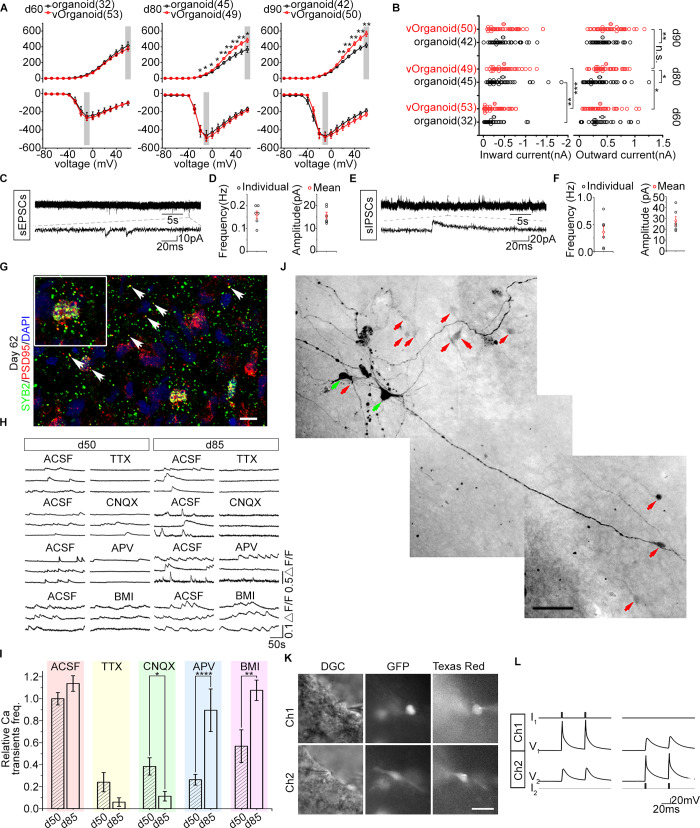
Electrophysiological properties of cells in the vOrganoids at different developmental stages.(A) The amplitudes of outward (upper) and inward (lower) currents from the organoids (black) and vOrganoids (red) cells at day 60 (32 cells from 5 organoids in 4 independent experiments; 53 cells from 8 vOrganoids in 6 independent experiments), day 80 (45 cells from 6 organoids in 4 independent experiments; 49 cells from 6 vOrganoids in 4 independent experiments, p-values: 0.0428, 0.0278, 0.0222, 0.0171, 0.0085, 0.0066, 0.0072, 0.0099, and 0.0131 when evoked voltages are −20, −10, 0, 10, 20, 30, 40, 50, and 60 mV) and day 90 (42 cells from 6 organoids in 4 independent experiments; 50 cells from 6 vOrganoids in 5 independent experiments, p-values: 0.0090, 0.0027, 0.0033, 0.0025, and 0.0018 when evoked voltages are 20, 30, 40, 50, and 60 mV). Two-sample t test, data shown as mean ± SEM, *p < 0.05, **p < 0.01, ***p < 0.001. (B) The amplitudes of outward currents elicited by +60 mV (indicated by gray box in upper panel of A) and the amplitudes of inward currents elicited by −10 mV (indicated by gray box in lower panel of A) from organoid (black) and vOrganoid (red) cells at day 60, day 80, and day 90. Open circles indicate the amplitude of current from individual cells. Filled circles indicate the mean value. p-Values: 0.0108 (outward current of vOrganoid d60 versus d80), 0.0615 (outward current of vOrganoid d80 versus d90), 0.0131 (outward current at day 80 organoid versus vOrganoid), 0.0018 (outward current at day 90 organoid versus vOrganoid), 0.0066 (inward current of organoid d60 versus d80), 0.00001 (inward current of vOrganoid d60 versus d80). Two-sample t test, data shown as mean ± SEM, *p < 0.05, **p < 0.01, ***p < 0.001. (C-F) Spontaneous EPSCs (C) and IPSCs (E) were recorded in vOrganoids. The average frequency and amplitude of EPSCs and IPSCs are shown in (D) and (F), respectively. n = 6, 6 cells from 3 organoid and 3 vOrganoids in three independent experiments for sEPSCs (D) and sIPSCs (F), respectively. (G) Synapses in vOrganoids are revealed by immunofluorescence staining for the pre- and postsynaptic markers, SYB2 and PSD95, respectively. Scale bar, 10 μm. (H) Intracellular spontaneous calcium fluctuations were measured before and after the application of TTX, CNQX, APV, and BMI in the vOrganoids at day 50 and day 85, respectively. (I) The effects of different treatments on spontaneous calcium fluctuations were compared between day 50 and day 85 in the statistical results. Relative Ca2+ transient frequencies are normalized with the ACSF data of day 50. There are 188 and 124 cells in total for day 50 and day 85. All data are presented as means ± SEM. n = 188, 124, 31, 9, 65, 33, 77, 36, 15, and 46 from three independent experiments. Two-sample t test, p_ACSF = 0.1266, p_TTX = 0.2798, p_CNQX = 0.0208, p_APV = 0.00005, p_BMI = 0.0075. *p < 0.05, **p < 0.01, ***p < 0.001, ****p < 0.0001. (J) Coupling pattern was visualized by cell injection. Green arrows indicated the injected cells. Red arrows indicated the cells that were connected to the injected cells. Scale bar, 50 μm. (K-L) The gap junctions between two cells (CMV-GFP labeled) were identified by dual-patch recording. The morphology of cells that dual patched was showed in (K). Scale bar, 50 μm in (K). The voltage deflections with small amplitudes were recorded in one cell while currents were injected into the other cell (L). The numerical data underlying this figure can be found in the Fig 3A, 3B, 3D, 3F and 3I sheets of S1 Data. ACSF, artificial cerebral spinal fluid; APV, DL-2-Amino-5-phosphonopentanoic acid; BMI, bicuculline methiodide; CMV, cytomegalovirus; CNQX, 6-Cyano-7-nitroquinoxaline-2,3-dione; DGC, dodt gradient contrast; GFP, green fluorescent protein; PSD95, postsynaptic density protein-95; sEPSC, spontaneous excitatory postsynaptic current; sIPSC, spontaneous inhibitory postsynaptic current; SYB2, synaptobrevin 2; TTX, tetrodotoxin; vOrganoid, vascularized organoid.